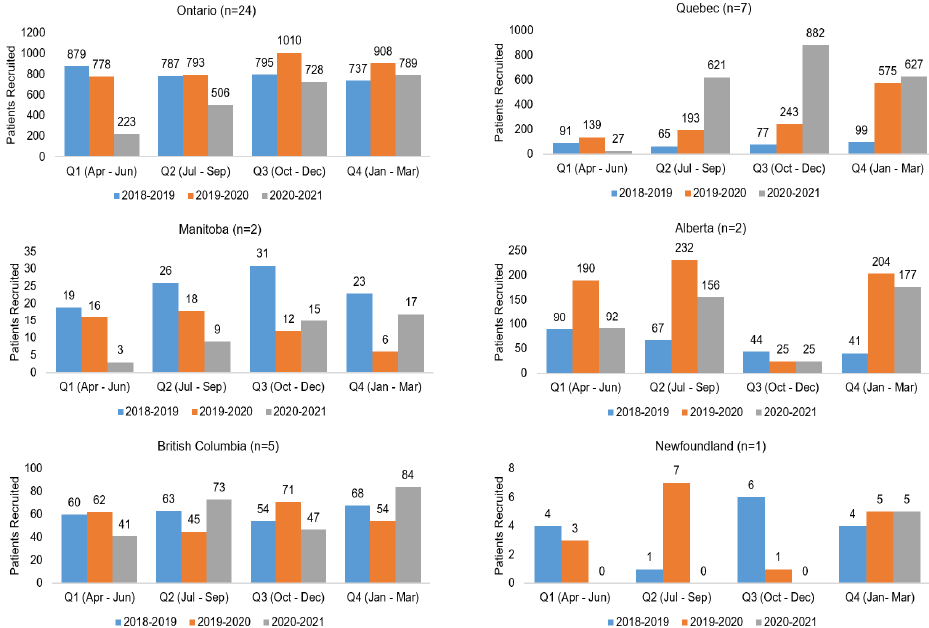
Figure A1. Recruitment to 3CTN Portfolio trials at adult cancer centers by province 1 April 2018–31 March 2021.